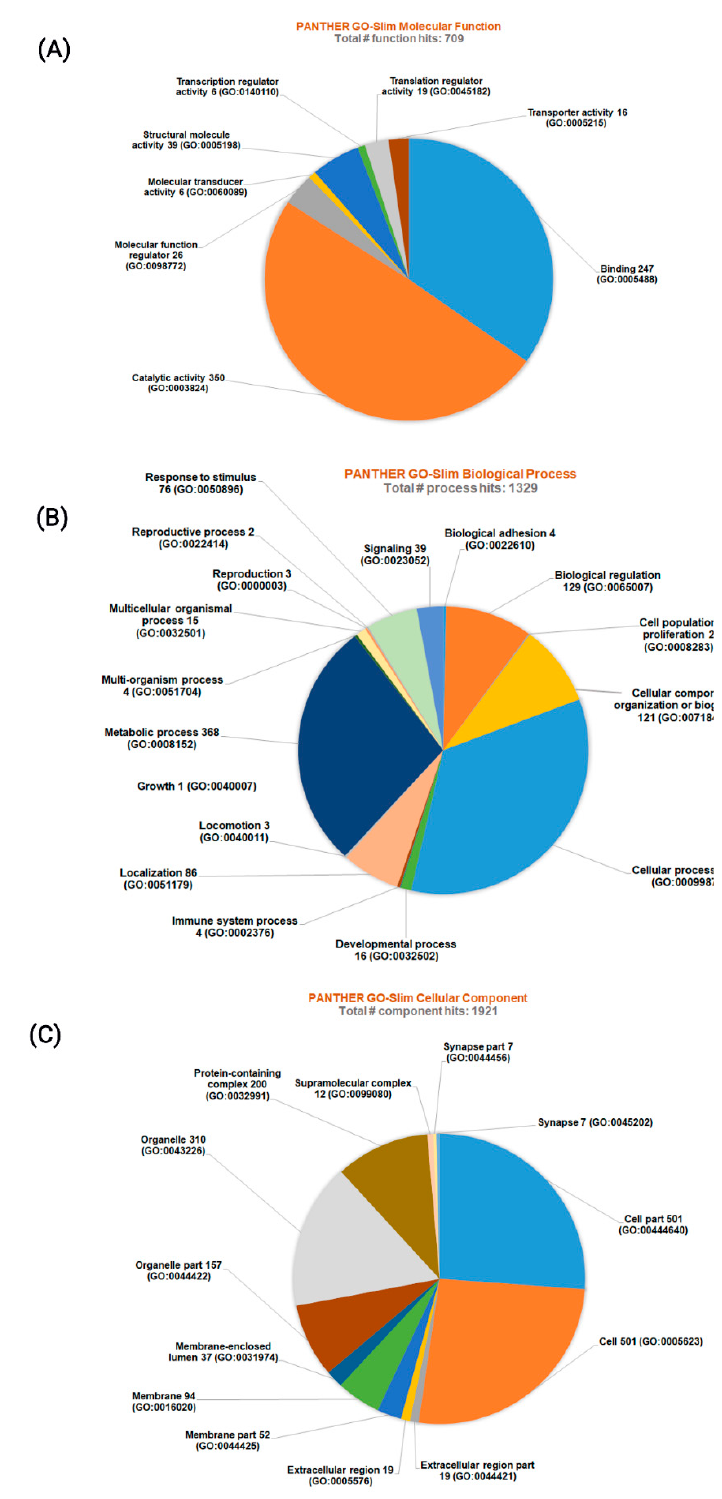
Figure 5. Classification of the 1089 proteins identified across all treatment groups based on the PANTHER GO analysis for ( A ) molecular functions, ( B ) biological processes and ( C ) cellular components. Numbers next to each family / subfamily name indicate the number of function (molecular function), process (biological process) and component (cellular component) hits. The protein grouping based on their cellular localizations resulted in 1921 total component hits. Among this group, proteins within a cell and in the organelles were predominant. Other groups observed were proteins that were part of extracellular regions, cell membranes and membrane